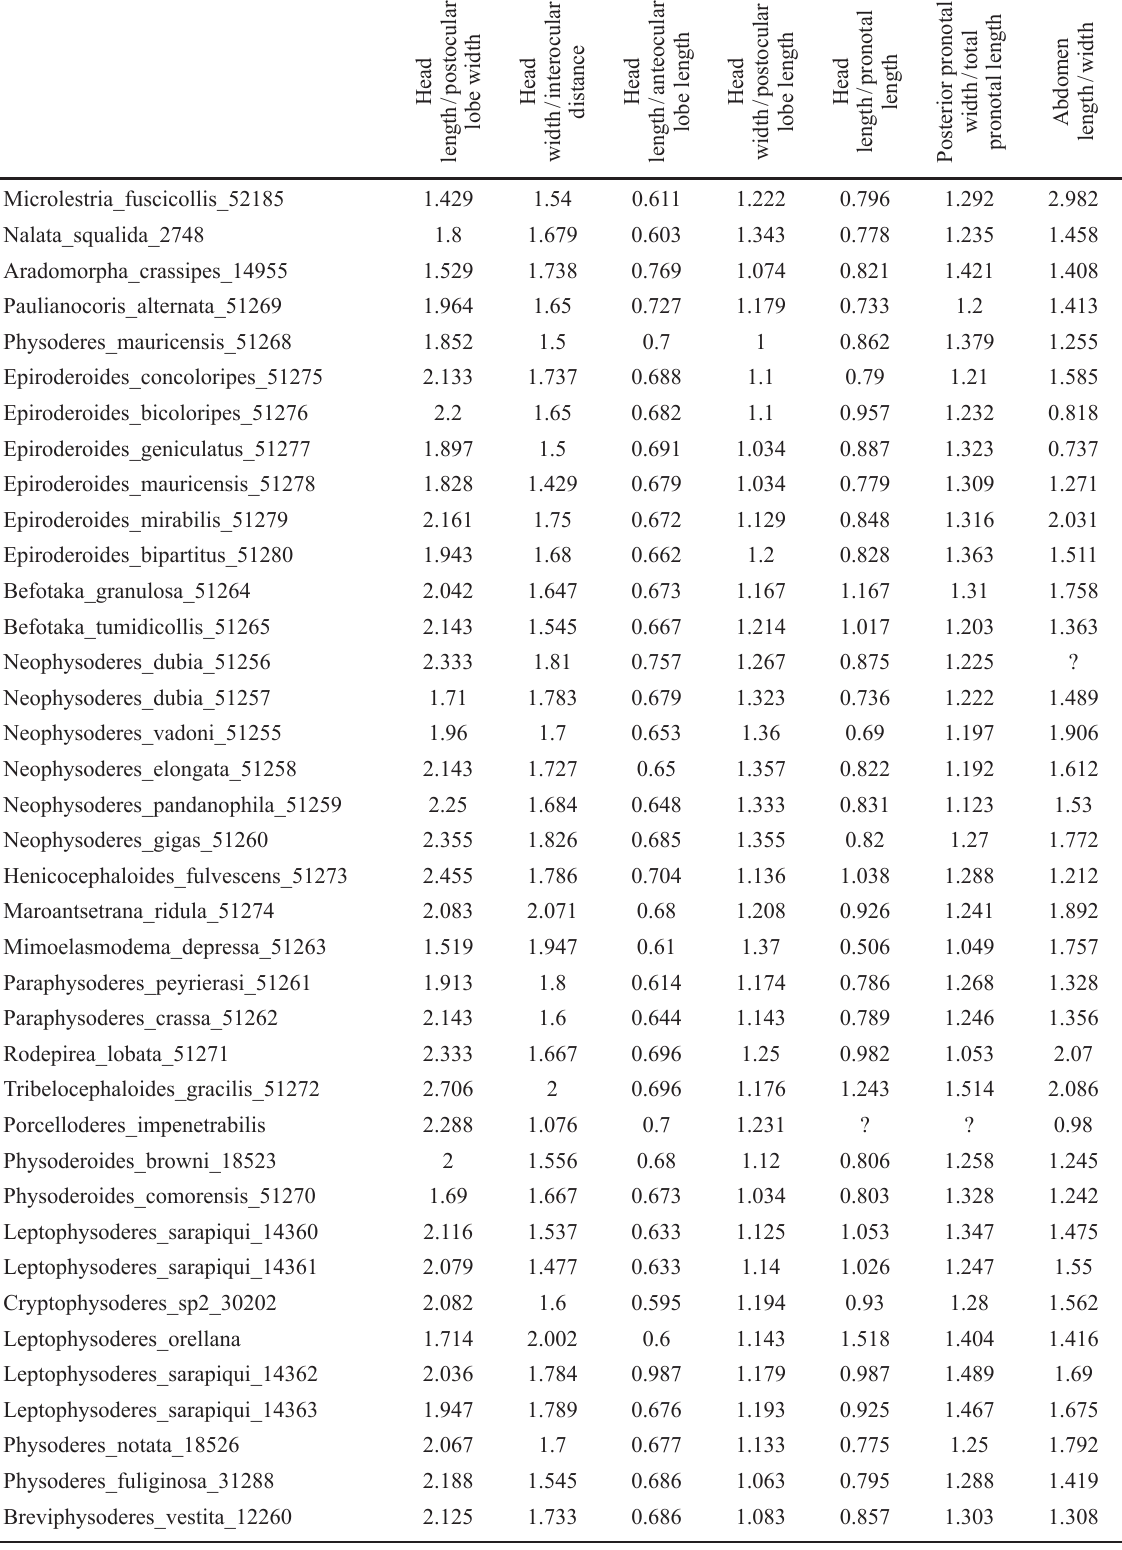
Table 2. Measurements used as continuous characters in matrix. Note: total pronotal length excludes antero-lateral tubercles and paramedian